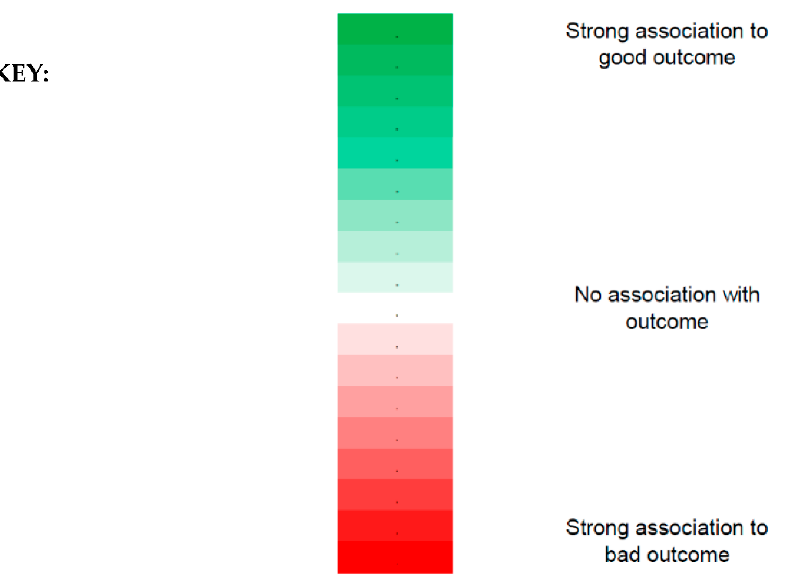
association to a bad outcome.